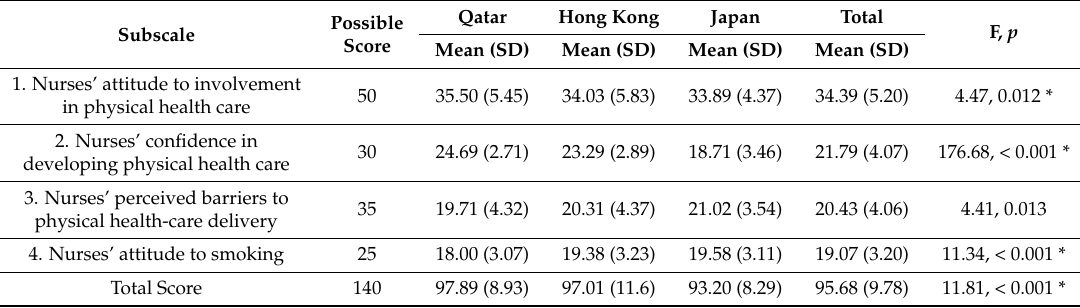
Table 3. Comparison of Physical Health Attitude Scale for mental health nurses (PHASe)subscale mean scores and total